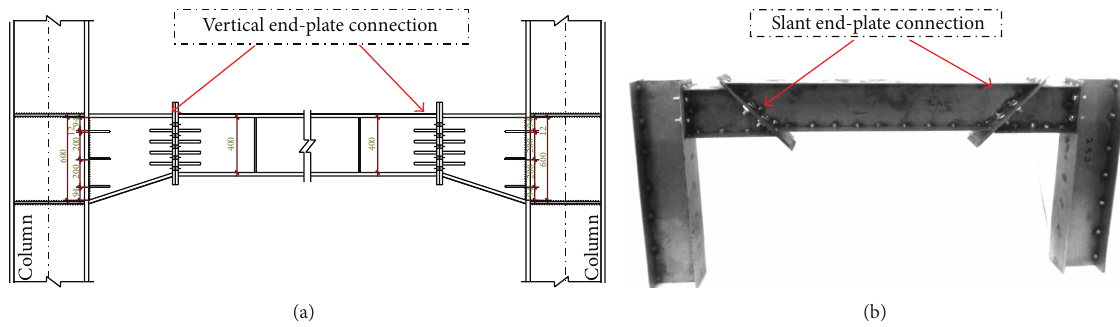
Figure 1: Typical beam with (a) vertical and (b) slant bolted end-plate